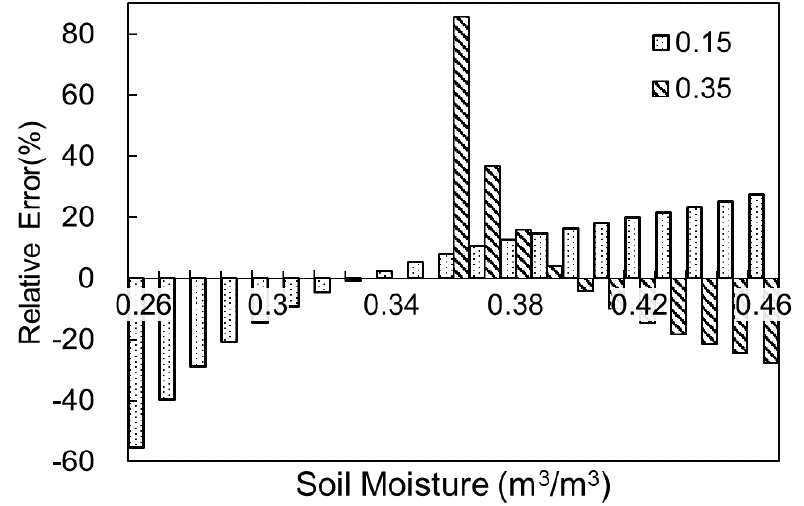
Figure 9. The impact of initial soil moisture in the scenarios ( 𝜃 0 = 0.15 and 𝜃 0 = 0.35).